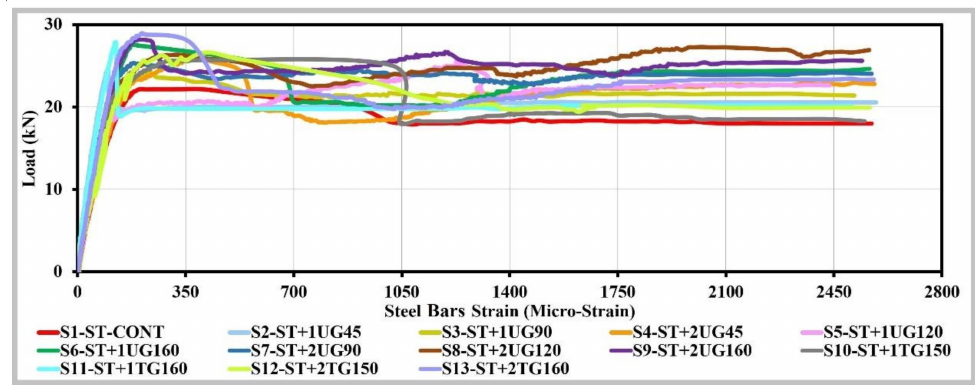
Figure 17. The load-strain curves of steel bars.